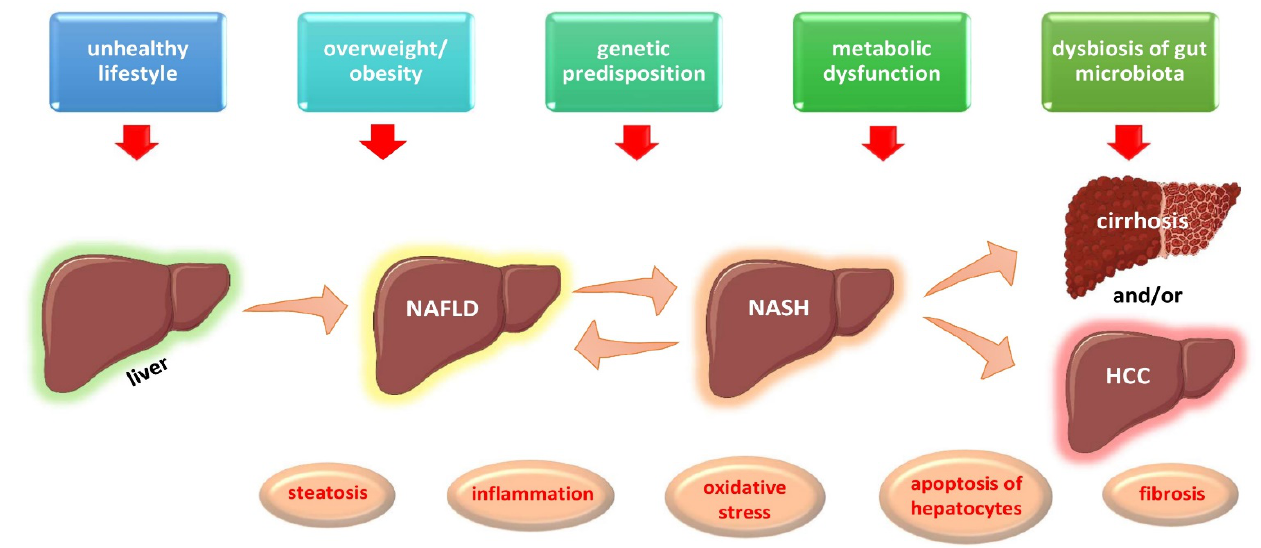
Figure 1. Multi-hit etiopathogenetic model of NAFLD progression and staging. Abbreviations: HCC, Hepatocellular Carcinoma; NAFLD, Non-Alcoholic Fatty Liver Disease; NASH, Non-Alcoholic Steatohepatitis. (All images are originated from the free medical website http://smart.servier.com/ by Servier licensed under a Creative Commons Attribution 3.0 Unported License, accessed on 1 October 2021).